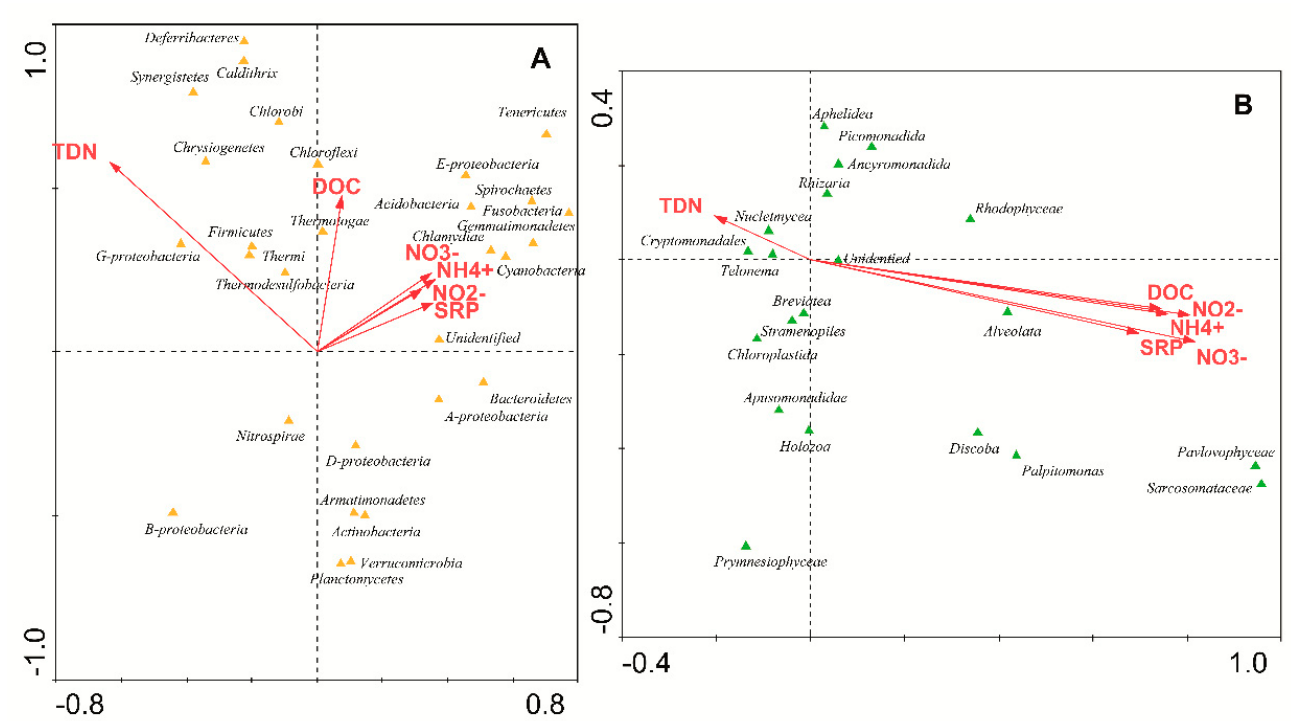
Figure 5. CCA of the microbial phyla of ( A ) bacteria and ( B ) microeukaryotes identified in glaciers with respect to the concentration of nutrients (NH 4+ , NO 2- , NO 3- , total dissolved nitrogen (TDN), soluble reactive phosphorous (SRP), and dissolved organic carbon (DOC)).